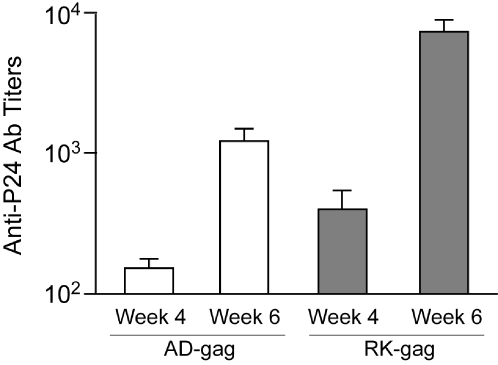
Immunogenicity of Gag DNA vaccines in mouse.The two different versions of Gag were made into DNA vaccines and injected into Balb/C mice with 25 µg/dose, then boosted at four weeks. Anti-Gag antibody levels were measured by ELISA at the four week and six week time points. The results are expressed as the geometric mean antibody titers (±SD) of each group. RK-Gag, induced an immune response that was five times larger than the codon optimized version at four weeks, which increased to a factor of 6 difference after six weeks.